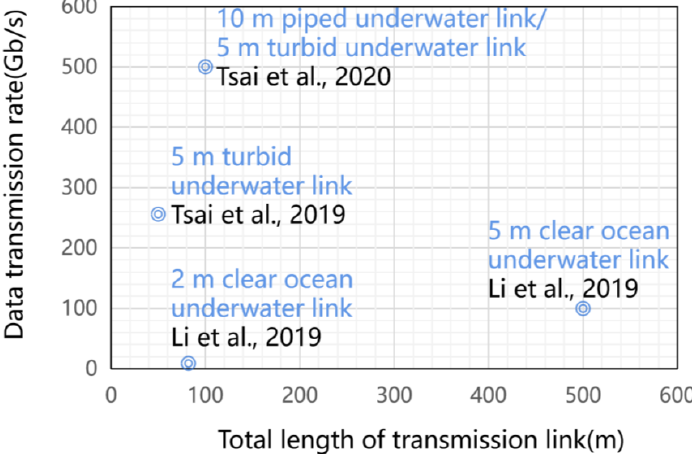
Figure 4. Recent applications of OIL in hybrid free space — UWOC systems. The total length of transmission link (x-axis) contains both underwater portion (blue) and free-space counterpart [33,34,35,36].